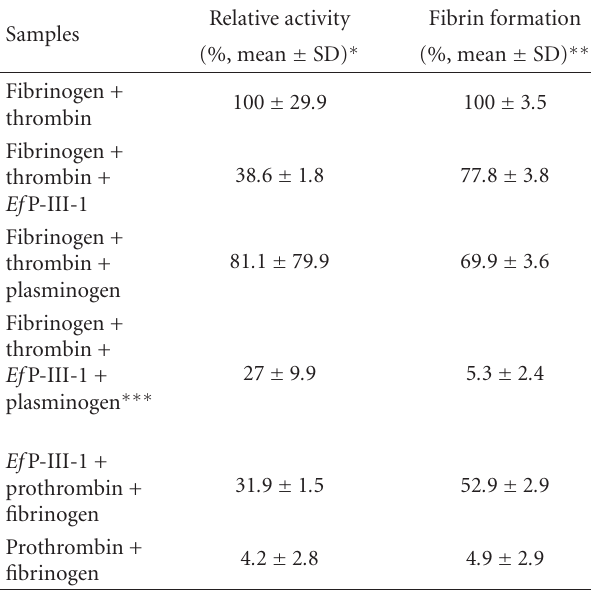
Table 2: Activities of fibrinogen, plasminogen, and prothrombin.